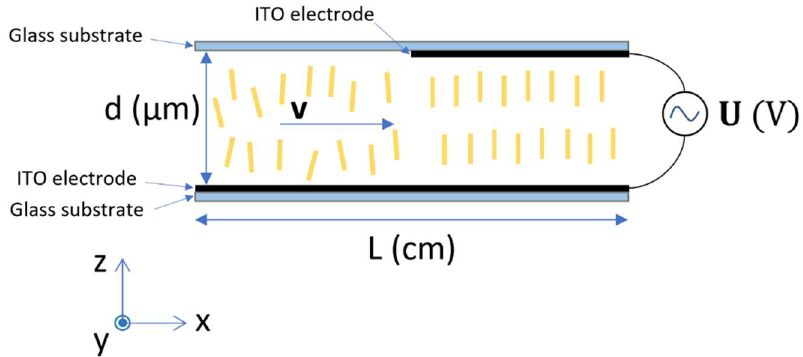
Figure 1. Schematic illustration of the considered cell: L is the length of the cell, and d is the distance between two substrates.